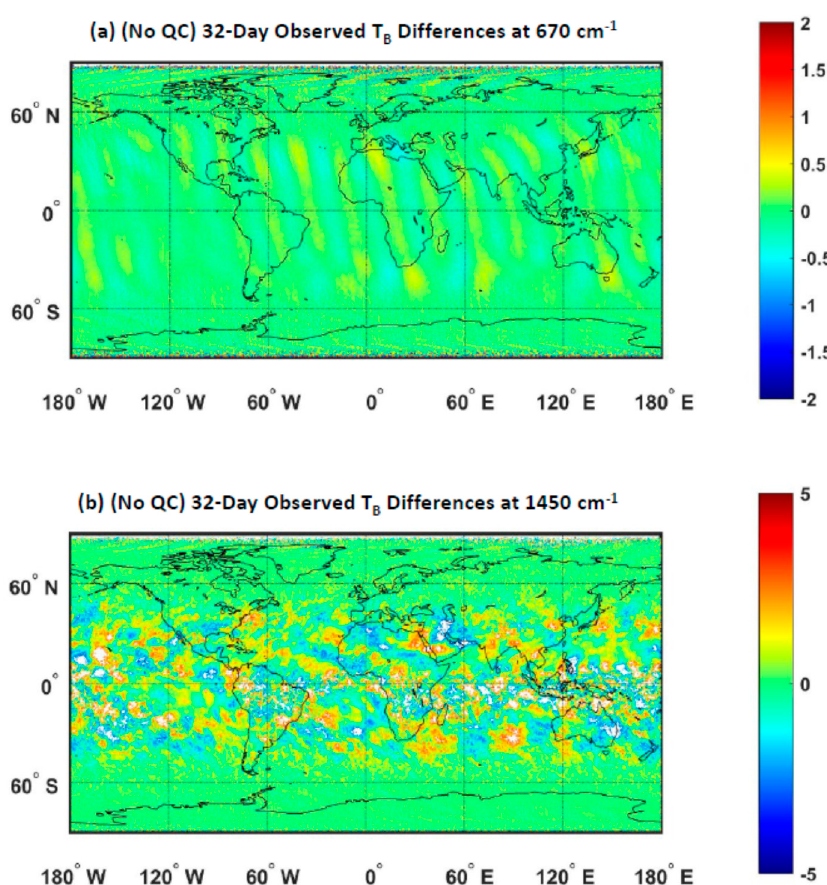
Figure 4. Global distributions of the 32-day-averaged brightness temperature differences (NOAA- 20 CrIS– SNPP CrIS) at two CrIS channels using Equation (5). The data cover the period from 27 September, to 28 October 2019: ( a ) 670 cm − 1 . ( b ) 1450 cm − 1 .